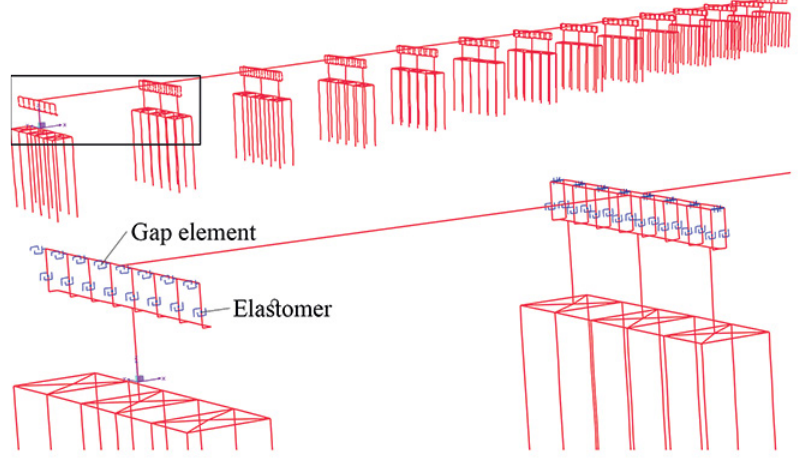
Figure 3. Three-dimensional finite element method of the investigated bridge and modelling